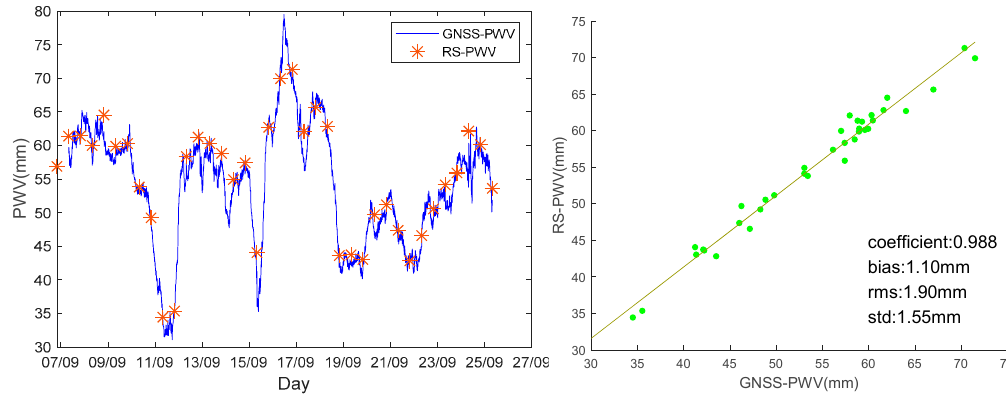
Figure 3. Comparison between the GNSS-precipitable water vapor (PWV) time series over the HKSC station and the discrete RS-PWV ( left ), and statistics of the differences between the two results shown in the left subfigure ( right ) during the period of 7–25 September.